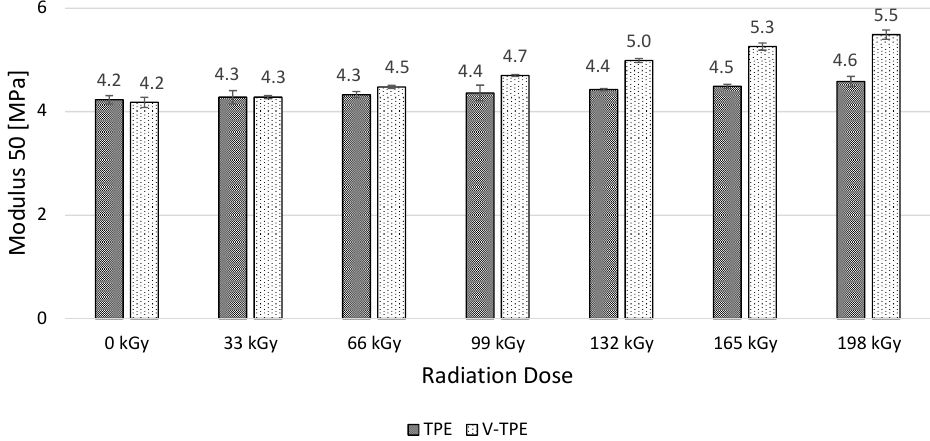
Figure 11. Modulus 50—TPE,